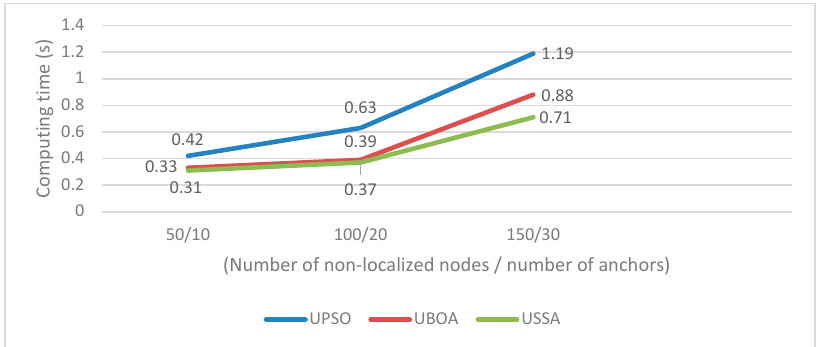
Figure 5. The computing time of the various localization algorithms in multiple UWSN deployments.